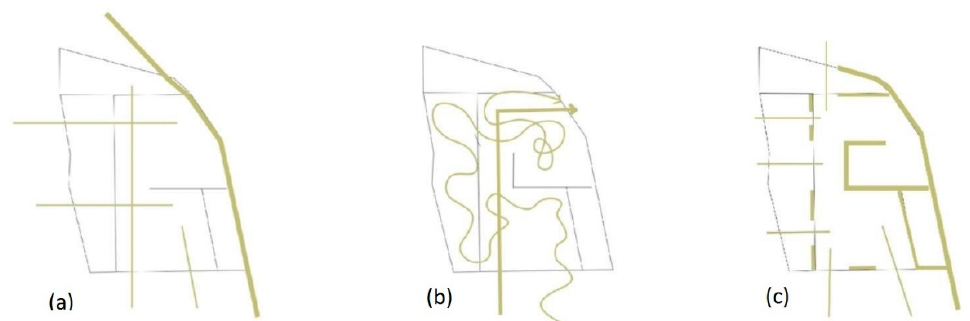
Figure 9. Tri Shala’s Space (third dimension of the design) ( a ) Tri Shala’s visual axes (Source: compiled by the author); ( b ) Tri Shala’s movement through space (Source: compiled by the author); ( c ) Tri Shala’s prospects and shelters (Source: compiled by the author).